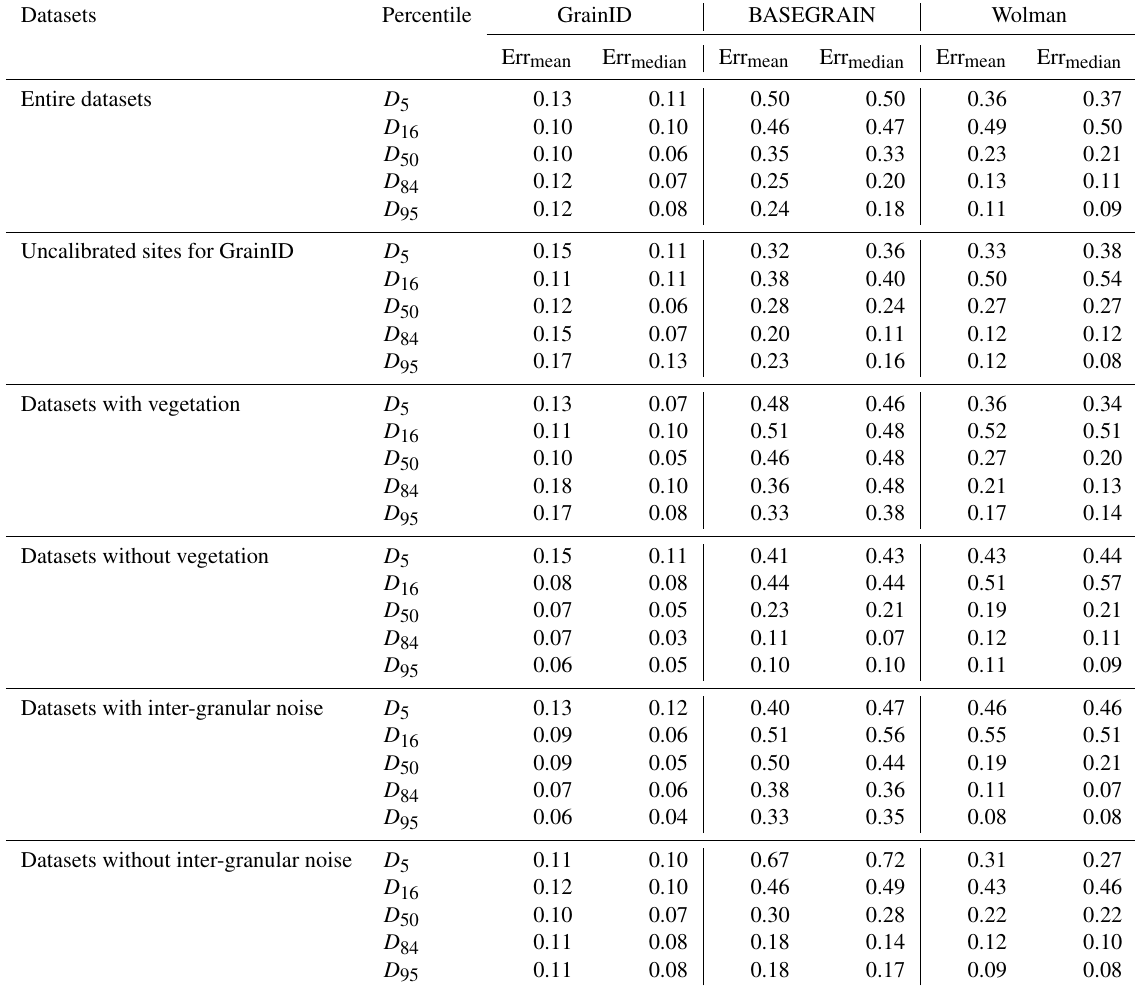
Table 3. Median and mean predicting error for different grain sizing methods and for different evaluating datasets with manual labeling as the baseline